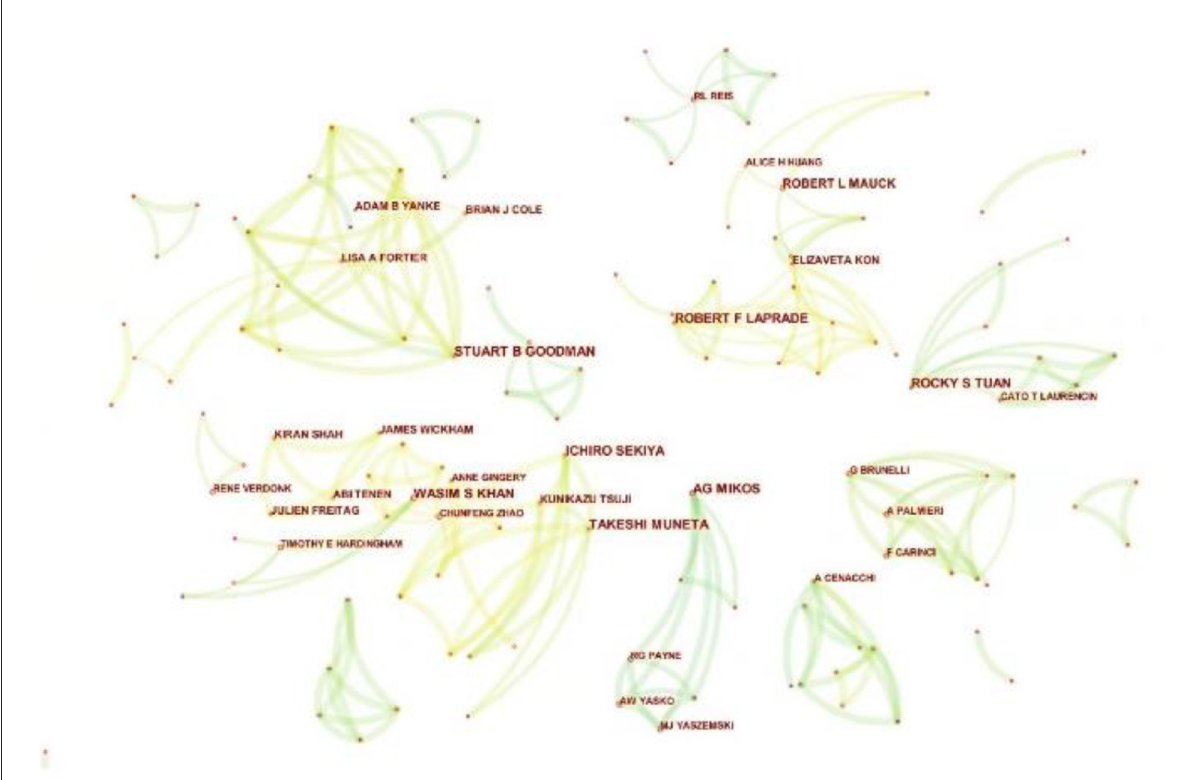
FIGURE5 The cooperation network map of productive authors related to MSCs in orthopedics from 2002–2021. Each node indicates an author, and different colors in the nodes indicate different publication years. At the same time, the connecting line between nodes indicates the collaborative relationship between authors.